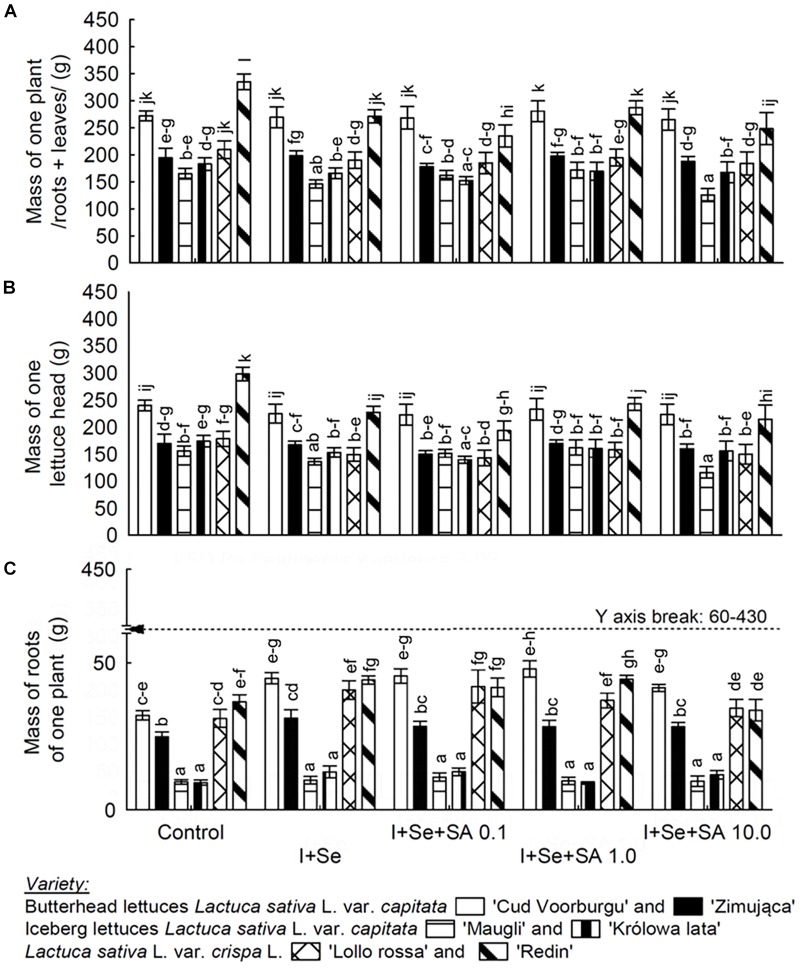
Effects of I, Se, and salicylic acid (SA) application on the whole biomass/roots + leaves per plant (A), mass of a single lettuce head (B) and roots per plant (C). Means followed by different letters for “Treatments × Variety” differ significantly at P < 0.05. Bars indicate standard error (n = 8).